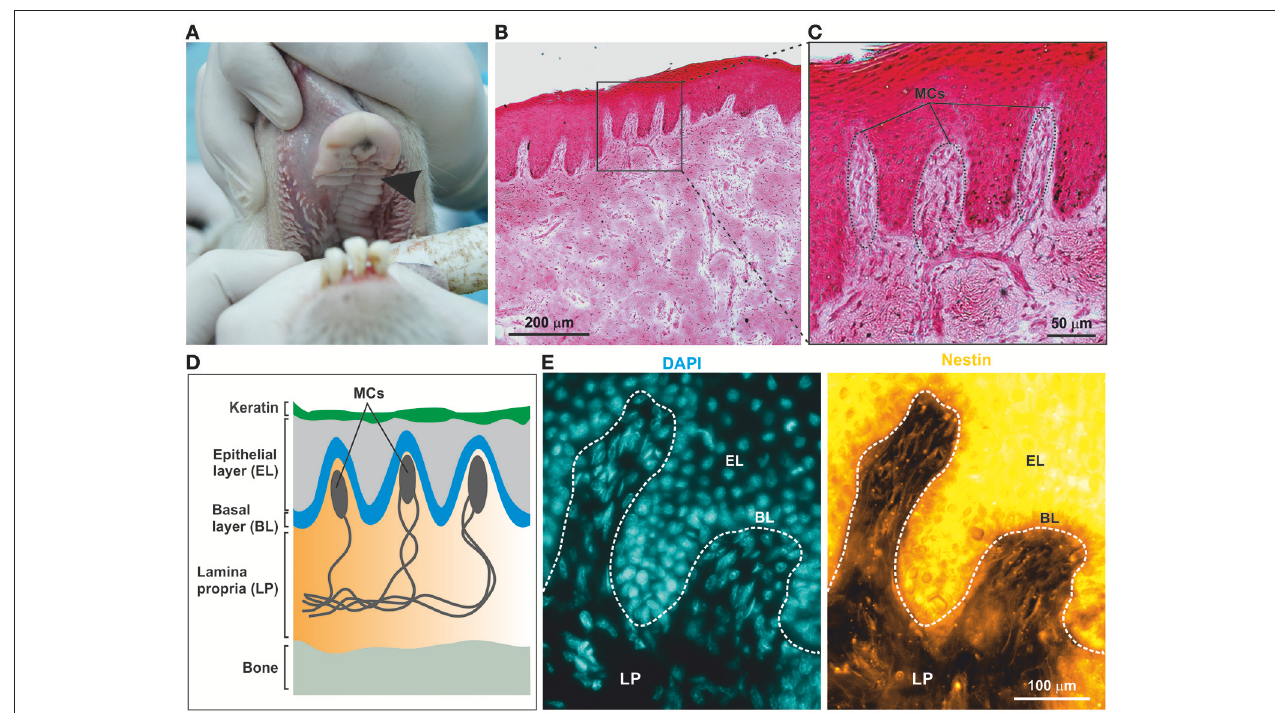
FIGURE 1 | Adult ovine hard palate contains neural crest-derived stem cells. (A) Tissue was isolated from ovine hard palate and sagittal sections were made along palatal ridges. Arrow indicates a palatal ridge. (B,C) Sagittal sections along ovine palatal ridges stained with Hematoxylin and Eosin revealed structure of Meissner corpuscles (MCs) localized within the palatal ridges. Scale bars: (B) 200 µ m; (C) 50 µ m. (D) Schematic drawing of MCs within the submucosa of palatal ridges. MCs are localized in the lamina propria (LP) of the palatal ridges underneath the keratin layer, the epithelial layer (EL), and the basal layer (BL). (E) Immunohistochemical stainings revealed the presence of Nestin-expressing oNCSCs (yellow) in the LP, especially within MC. Nuclear counterstaining was performed using DAPI (cyan). Scale bar: 100 µ